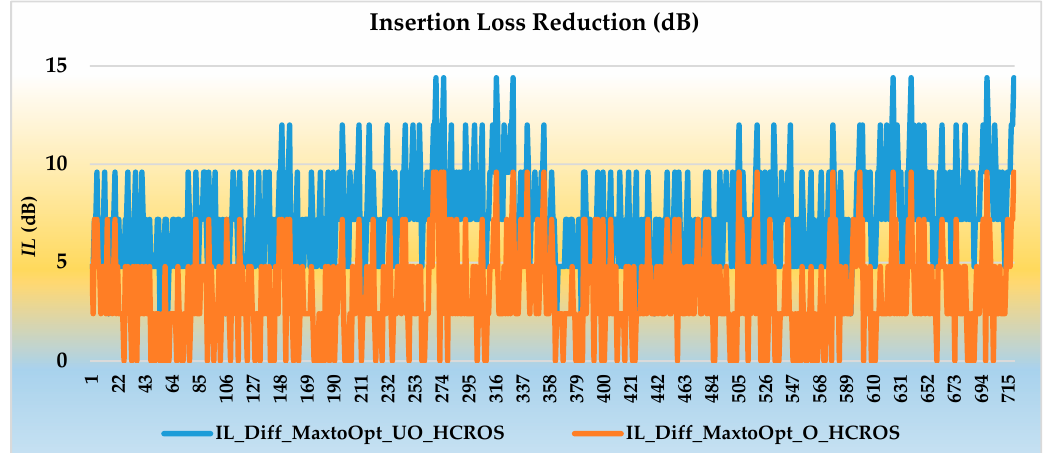
Figure 20. Average insertion loss IL(dB) of un-optimized and optimized HCROS for all I/O links.